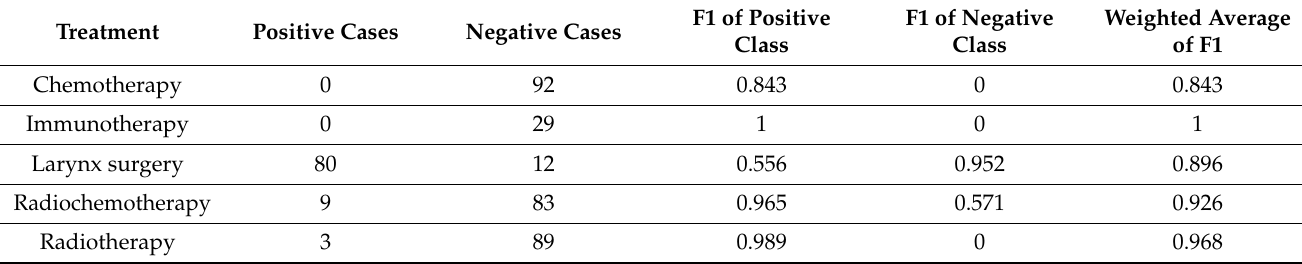
Table 4. F 1 measure for larynx